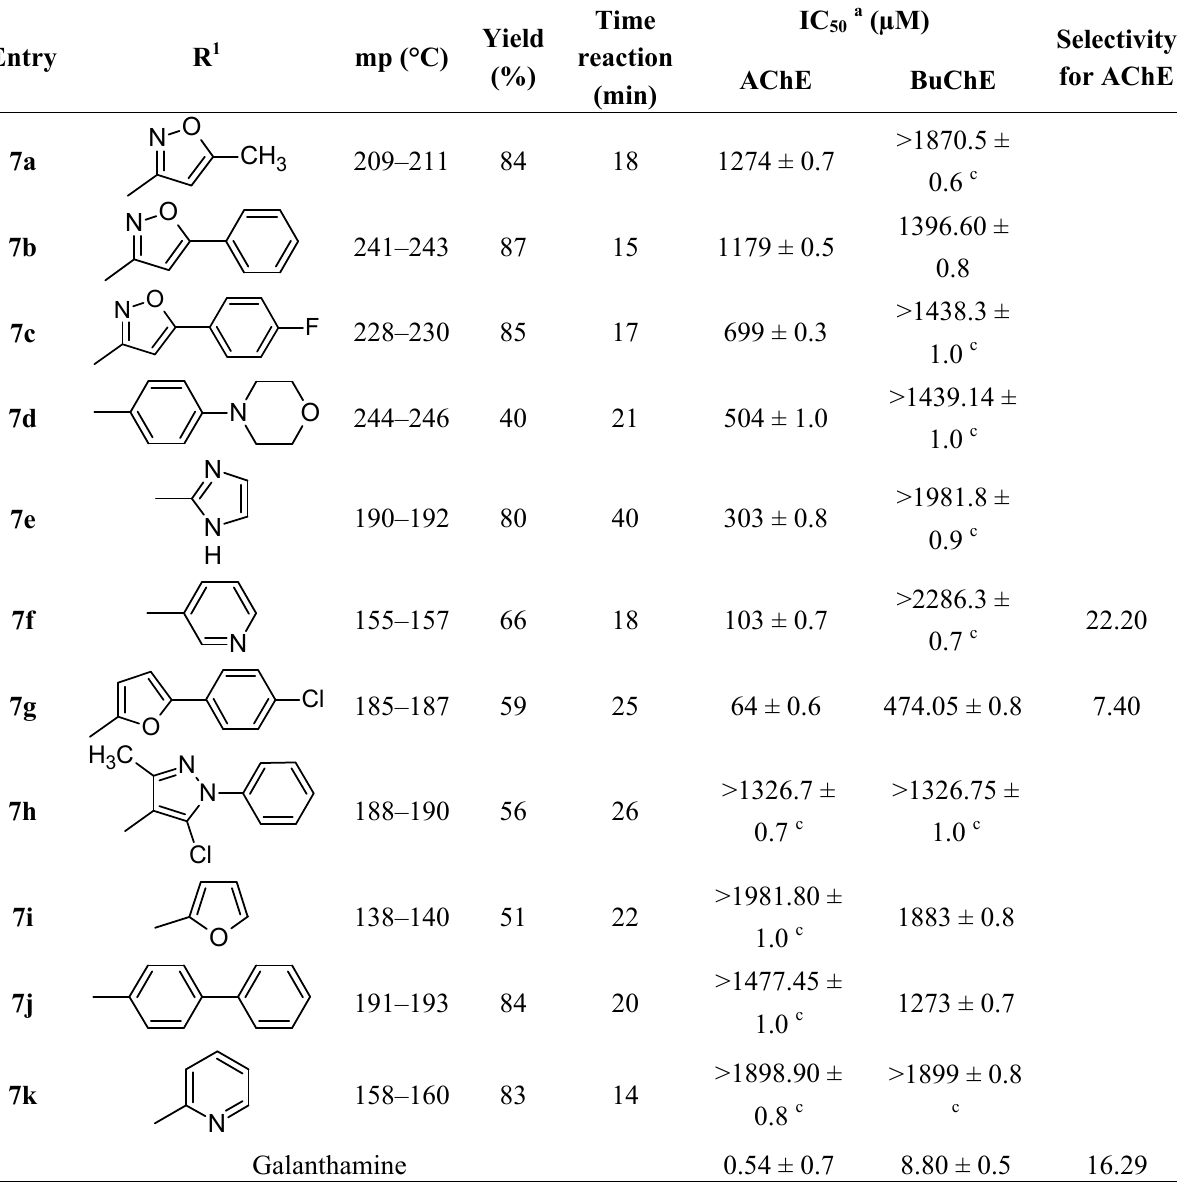
Table 1. Structures of compounds 7a – k and AChE inhibitory